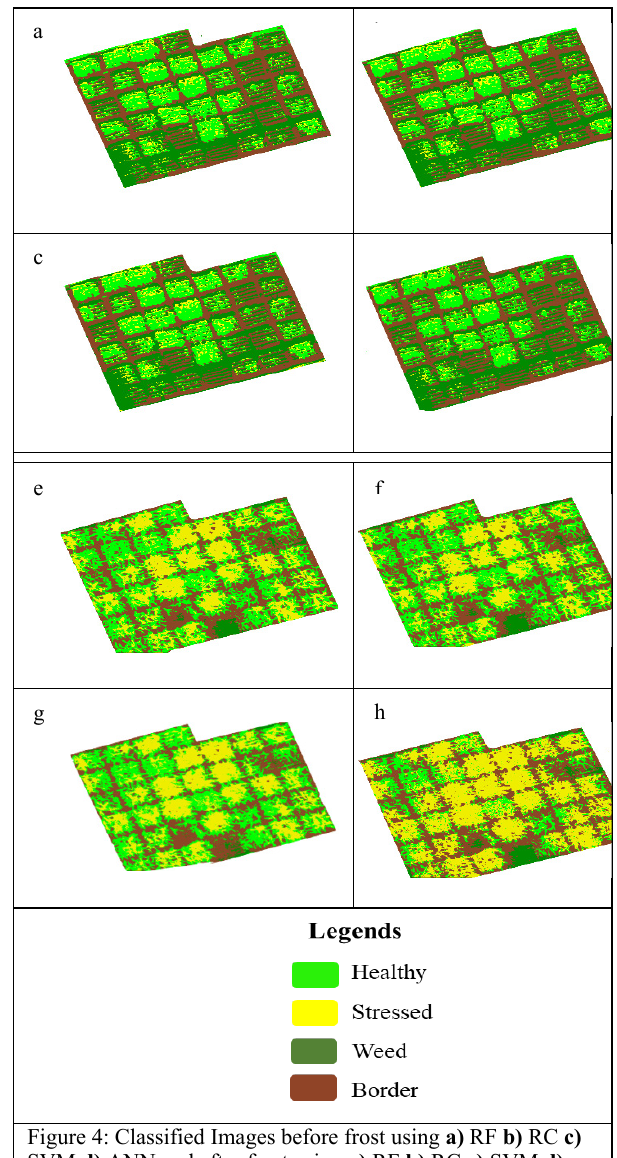
Figure 4: Classified Images before frost using a) RF b) RC